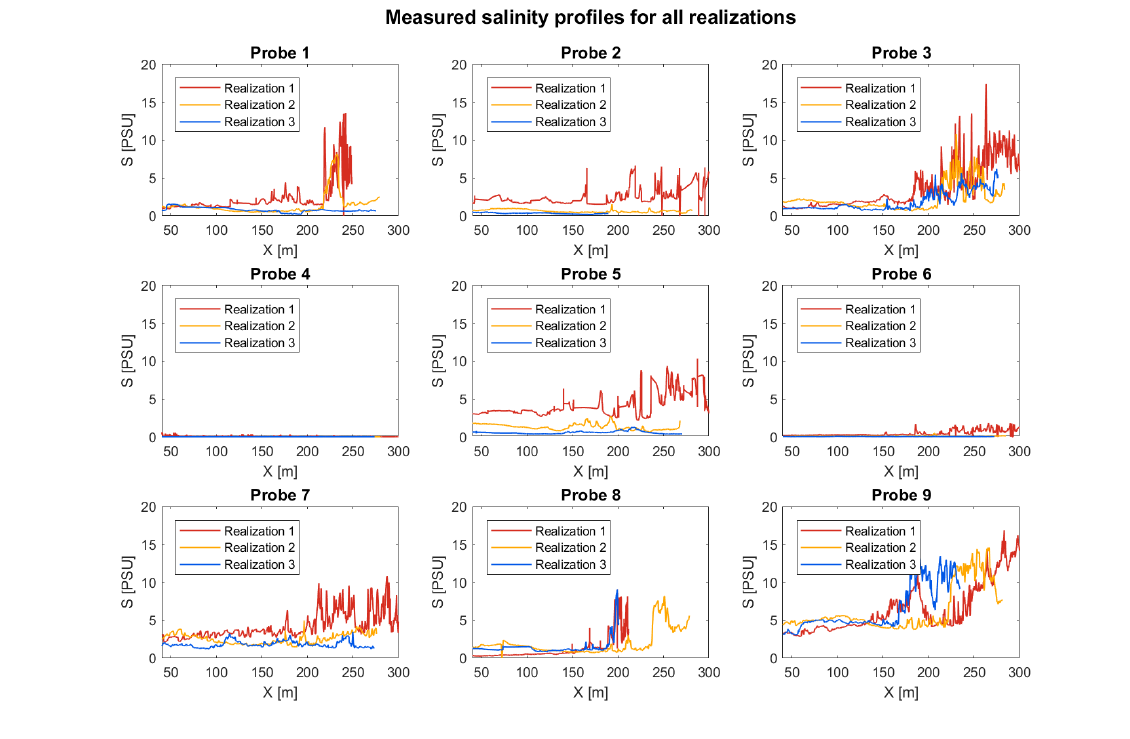
Figure 18. Measured salinity in practical salinity units